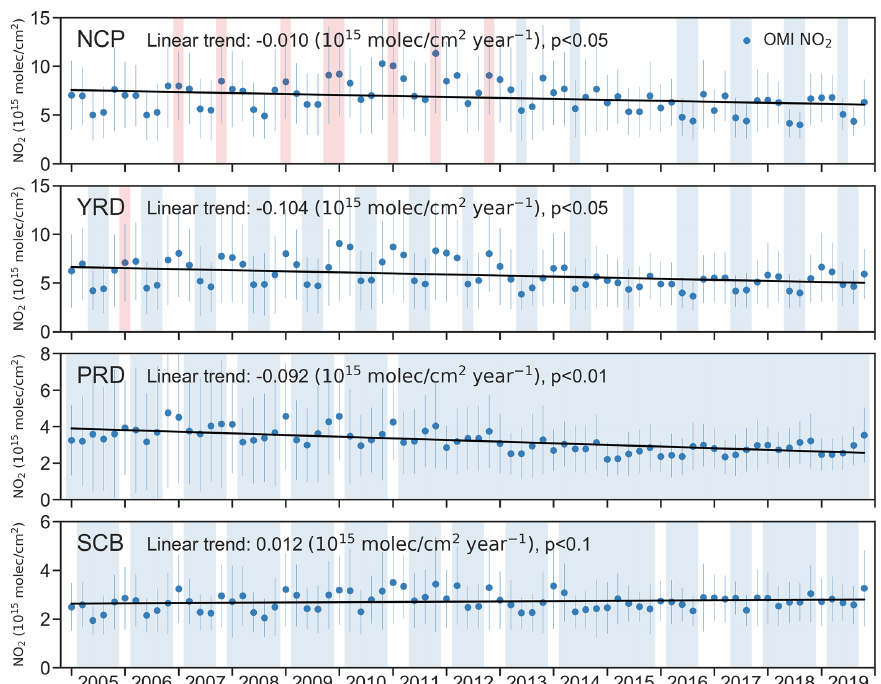
Figure 7. The time series of NO 2 columns in the four megacity clusters from 2005 to 2019. Black lines indicate the linear trend of NO 2 columns. Red, white, and blue areas stand for VOC-limited, transitional, and NO x -limited regimes, respectively.